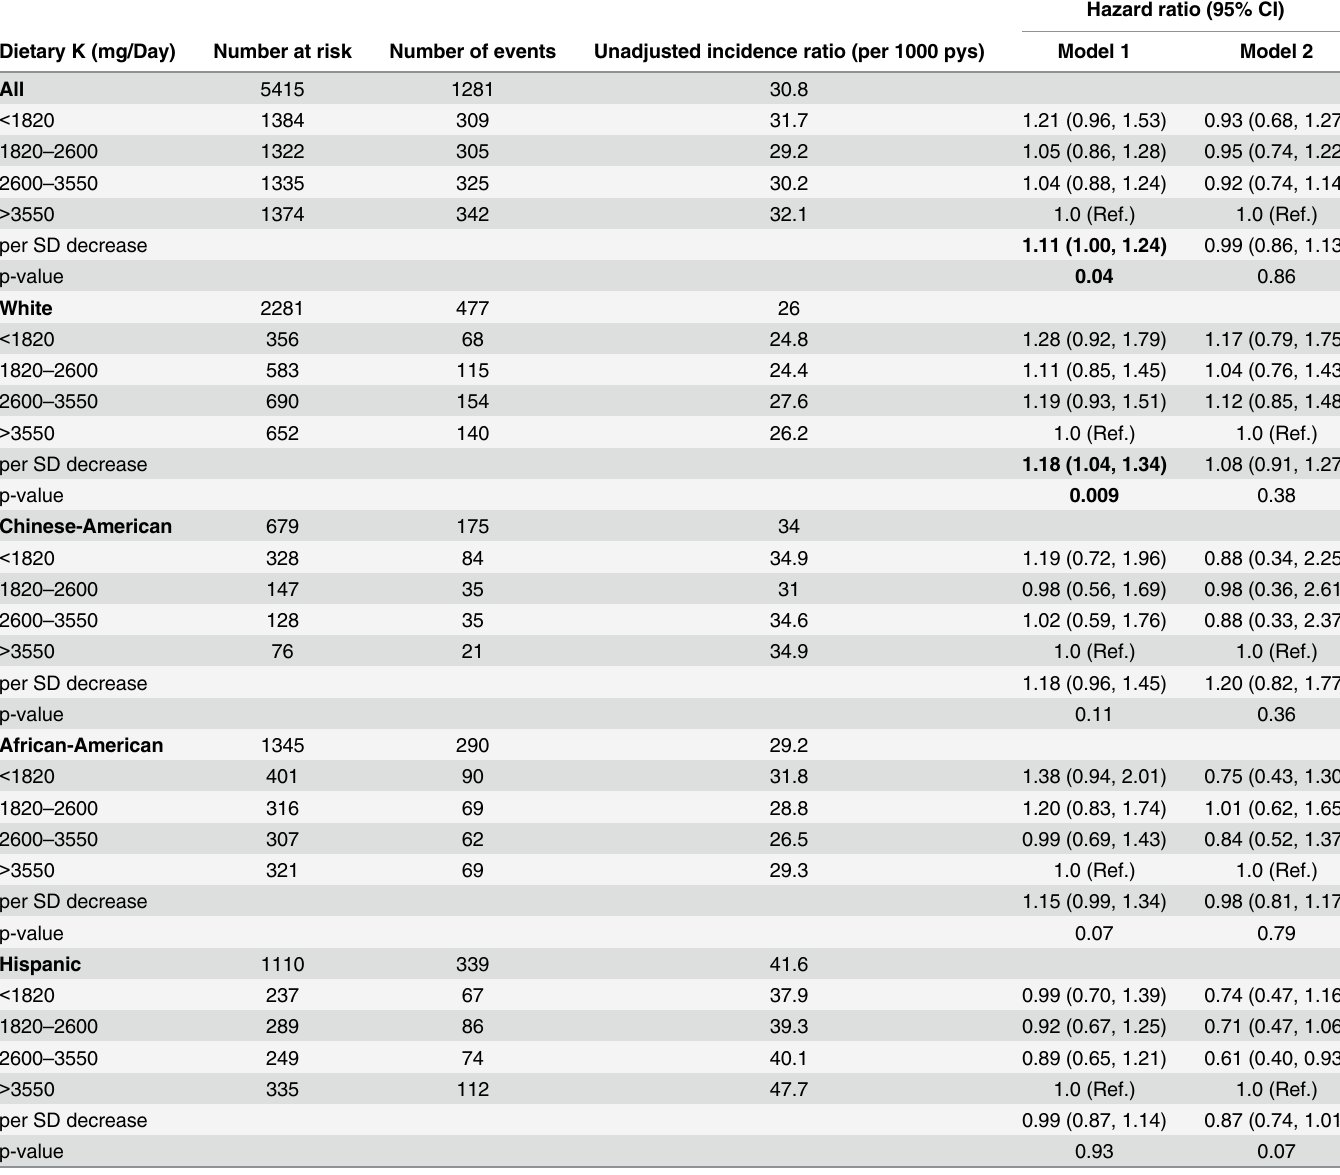
Model 1: adjusted for age (continuous), sex, race, study site, and total energy intake. systolic blood pressure, antihypertensive medication use and use of other medications listed in Table 1. Signi fi cant associations in bold. Race * dietary potassium, P = 0.46